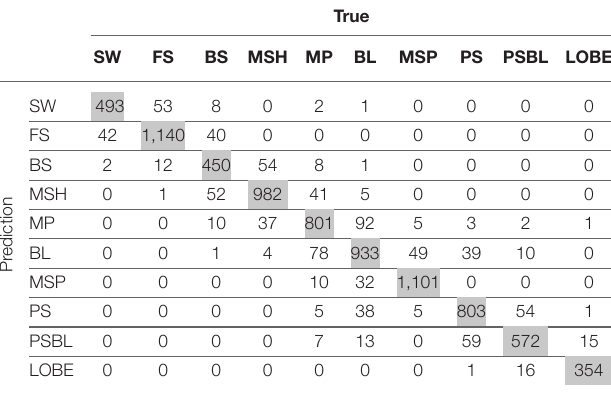
TABLE 4 | Confusion Matrix for FCN computed on the test